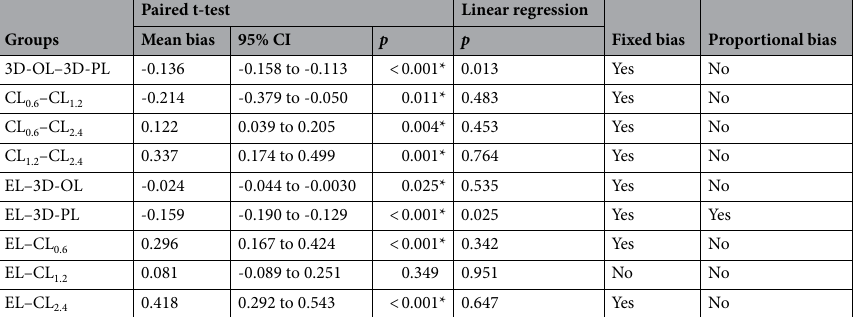
Table 3. Mean biases, confidence intervals, p values in two statistical tests, fixed or proportional biases among methods’ estimations. *Differences at significant level of 0.05. 3D-PL: Proposed length; 3D-OL: Operator length; EL: Electronic length; AL: Actual length. CL 0.6 : CBCT length at slice thickness of 0.6 mm. CL 1.2 : CBCT length at slice thickness of 1.2 mm. CL 2.4 : CBCT length at slice thickness of 2.4 mm.